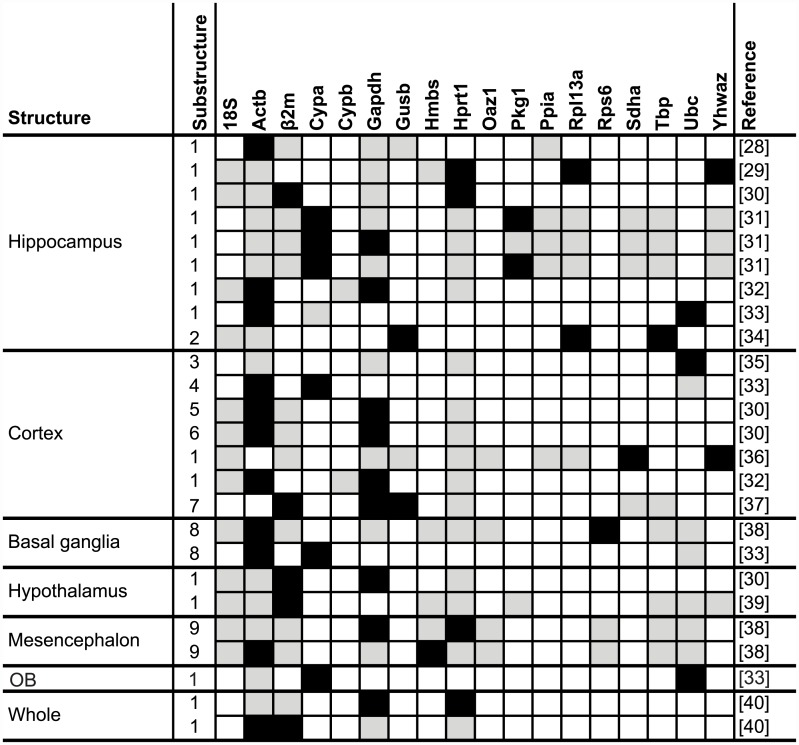
Testing and selection of RGs in different structures of the rat brain after various treatments.Shading in grey indicates the gene was tested and black indicates it was selected as within the group of most stable genes required for accurate normalisation. OB is the olfactory bulb with cerebral substructure codes provided as a footnote. Only genes tested more than once included. See S4 Table for further details of each study, including treatment regime and full list of all RGs tested and selected. a
Substructures: 1 = Whole, 2 = Dendate gyrus, 3 = Auditory, 4 = Prefrontal, 5 = Frontal, 6 = Temporal, 7 = Whole + Basal ganglia, 8 = Striatum, 9 = Nigra.